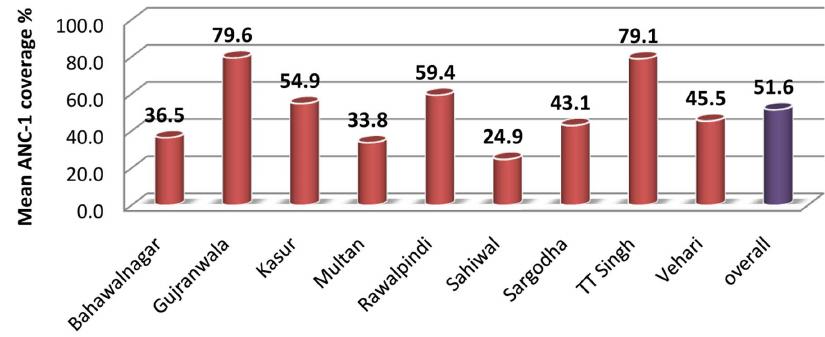
Figure 1. District-wise and overall mean annual ANC-1 coverage in PHC health facilities.